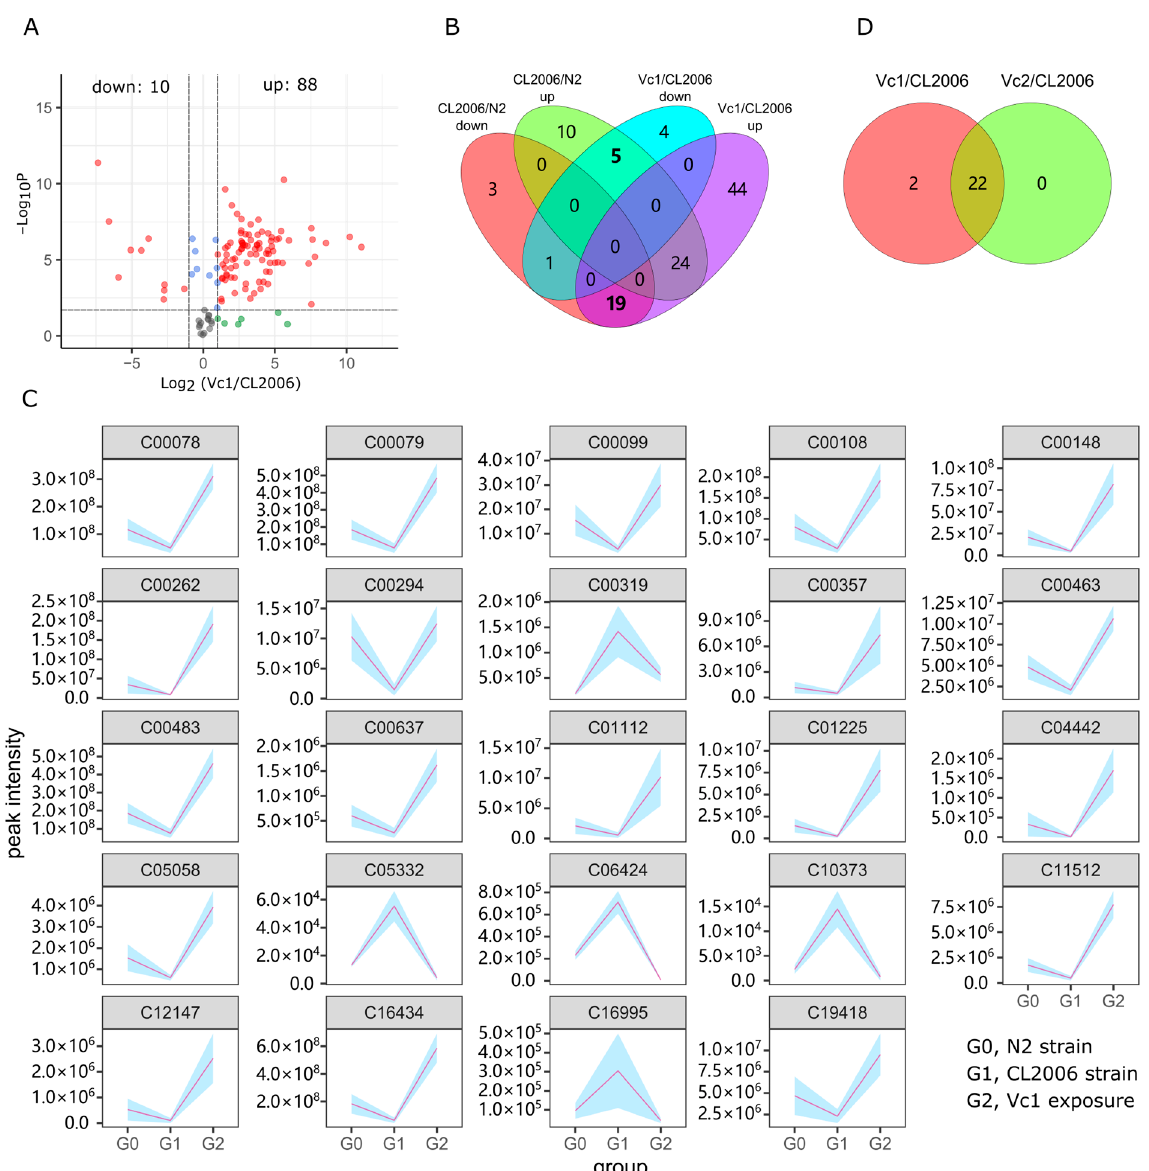
Figure 4. Vc restoration of metabolic disorder in AD. ( A ) Metabolite variation in the contrast of Vc1/CL2006. Red scatter, FC > 2.0, p < 0.02; blue scatter, FC ≤ 2.0, p < 0.02; green scatter, FC > 2.0, p ≥ 0.02; grey scatter, FC ≤ 2.0, p ≥ 0.02. The relevant comparative data are shown in Table S3 in supplementary materials. ( B ) The number distribution of up- and downregulated metabolites. ( C ) Trends of key metabolites, p < 0.02. Designators beginning with the letter C represent the KEGG compound ID. The shaded backgrounds under the lines represent the standard deviations. ( D ) The number of differential metabolites in the contrasts of Vc1/CL2006 and Vc2/CL2006, Fold Change > 2.0, p <